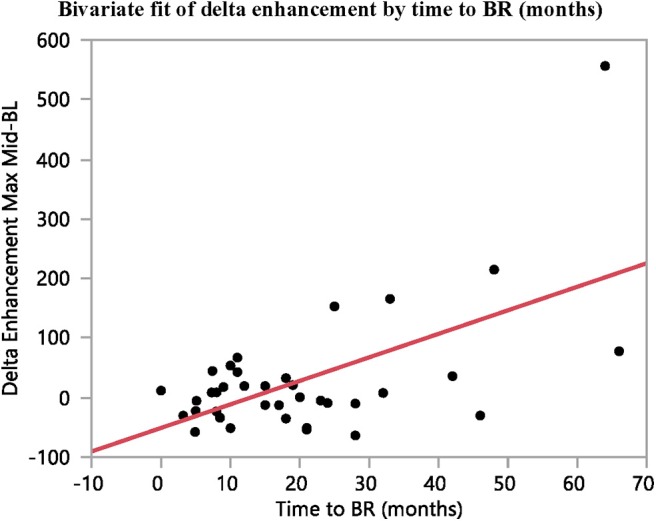
The difference in contrast-enhancement during early stages of treatment (baseline to mid-treatment) correlates with time to BR (n = 37, R2 = 0.34, p = 0.0001).